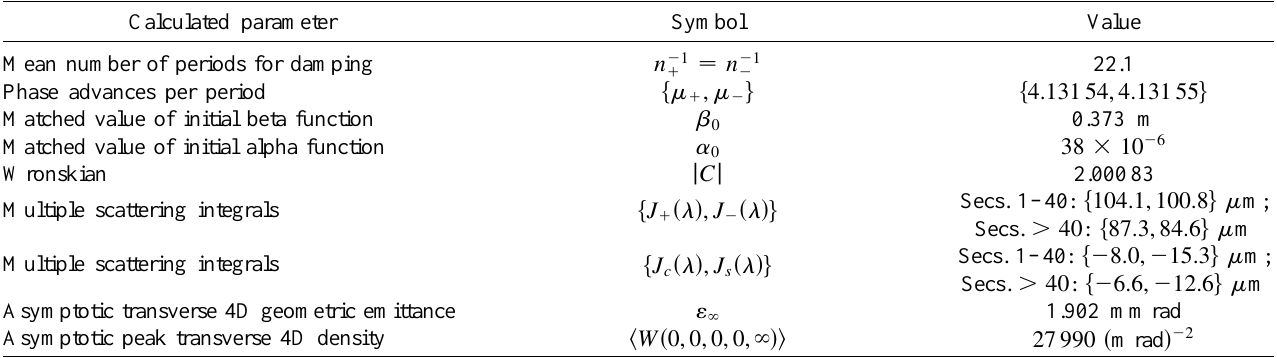
TABLE II. Calculated parameters of cooling channel and cooled beam.